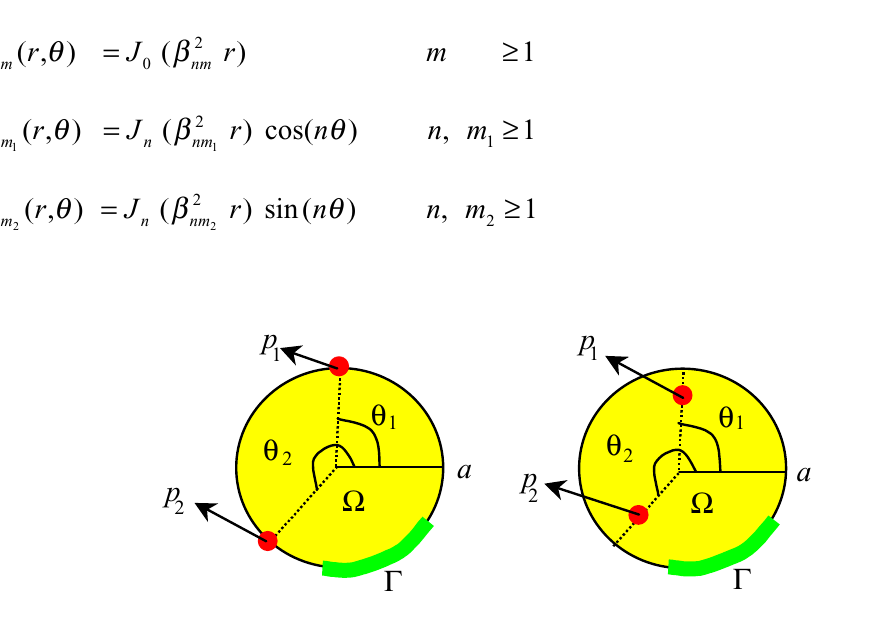
Figure 5. Domain Ω , region Γ and locations